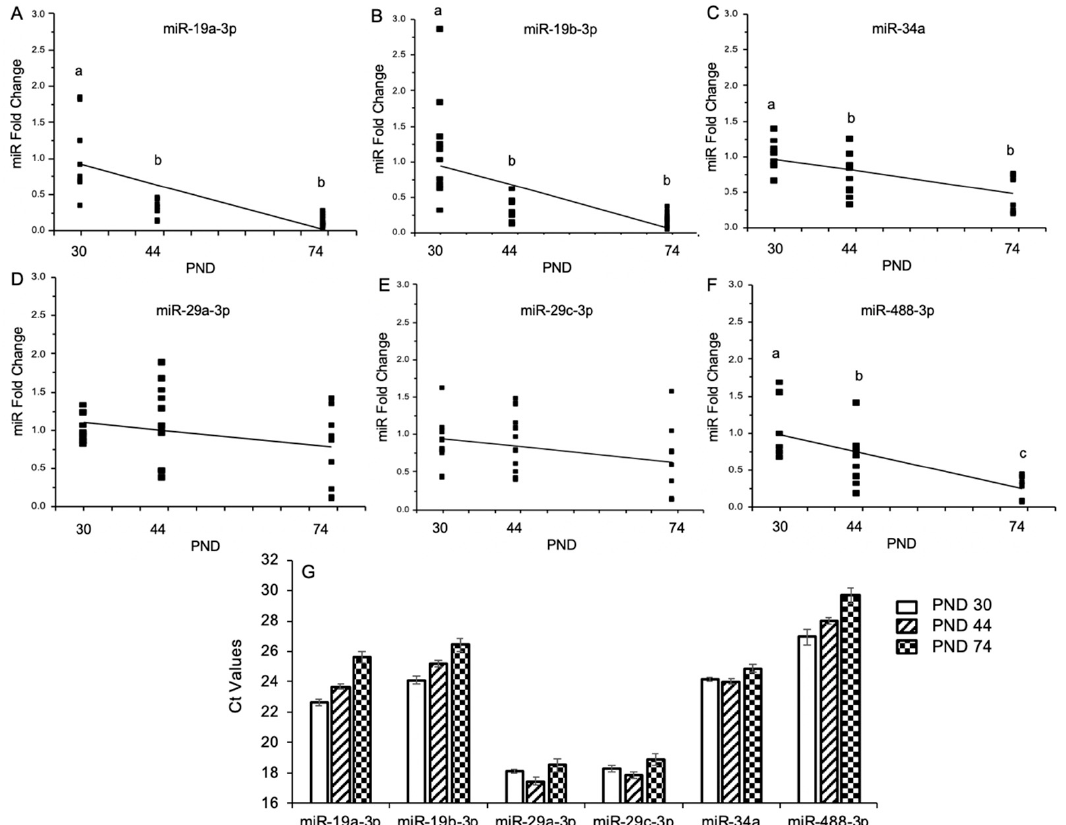
Figure 6. microRNA (miR) expression profile in the ventral hippocampus during male pubertal development. ( A – F ) Fold change differences in mature miR expression levels at PND 30, 44, and 74 as analyzed by ∆∆ Ct method. Data are depicted as a scatter plot for each animal in each group, overlaid with a line of best fit. Dissimilar lower-case letters indicate statistically significant difference between groups. ( G ) Raw qPCR Ct values of mature miRs demonstrating relative abundance in the ventral hippocampus across pubertal development. Data are depicted as mean ± SEM. N = 10/age group Ct = cycle threshold.